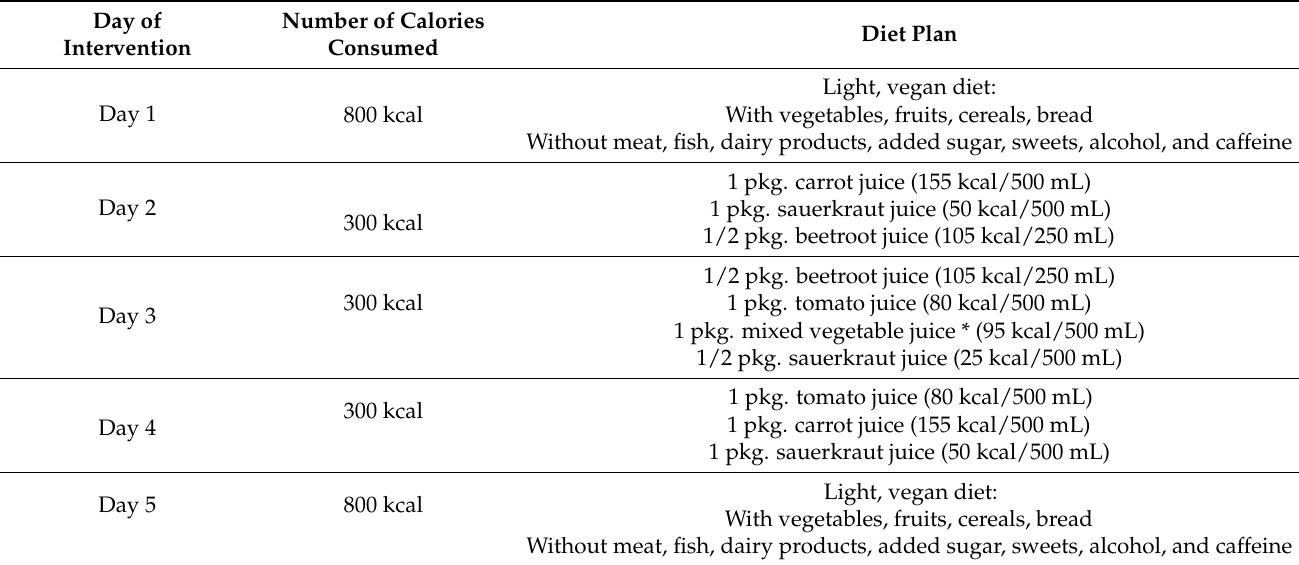
Table A1. Details of the diet during the 5-day fasting